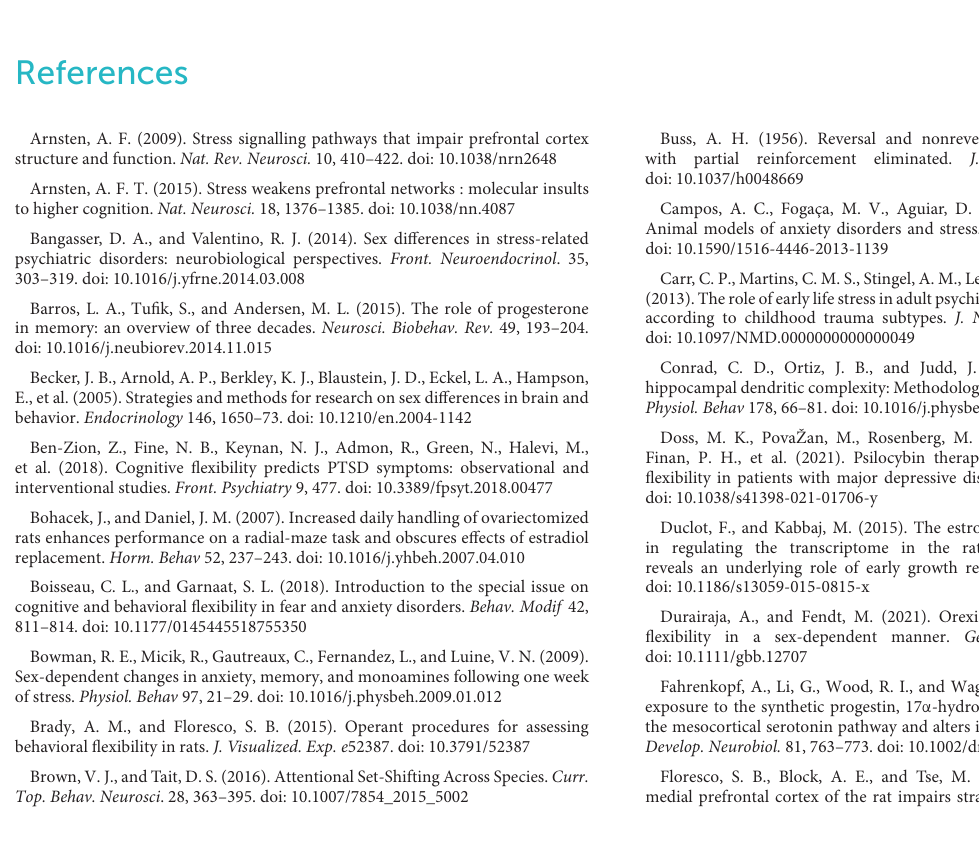
main effect on the number of omissions in the side discrimination task. (B) Stress increased the latency to first press in the side discrimination task. (C) Gonadal hormone status had a main effect on the number of omissions in the side reversal task. (D) Control animals demonstrated more omissions than stressed animals in the side reversal task. (E) Gonadal hormone status had a main effect on the number of perseverative errors in the light discrimination task. (F) Gonadal hormone status had a main effect on the number of omissions in the light discrimination task. ( n = 31 control, 30 stress; n = 21 male, 28 diestrus/estrus female, and 12 proestrus female rats). SUPPLEMENTARYFIGURE8 Main effects of stress, sex, or gonadal hormone status displayed in graph format for original Figure 9 data. (A) Female rats have a higher number of orexin-expressing cells than male rats. (B) Gonadal hormone status has a main effect on the number of orexin-expressing cells in the